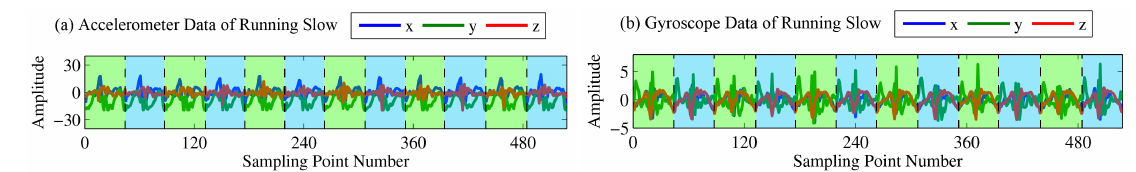
Figure 17. Accelerometer ( a ) and gyroscope ( b ) data of running